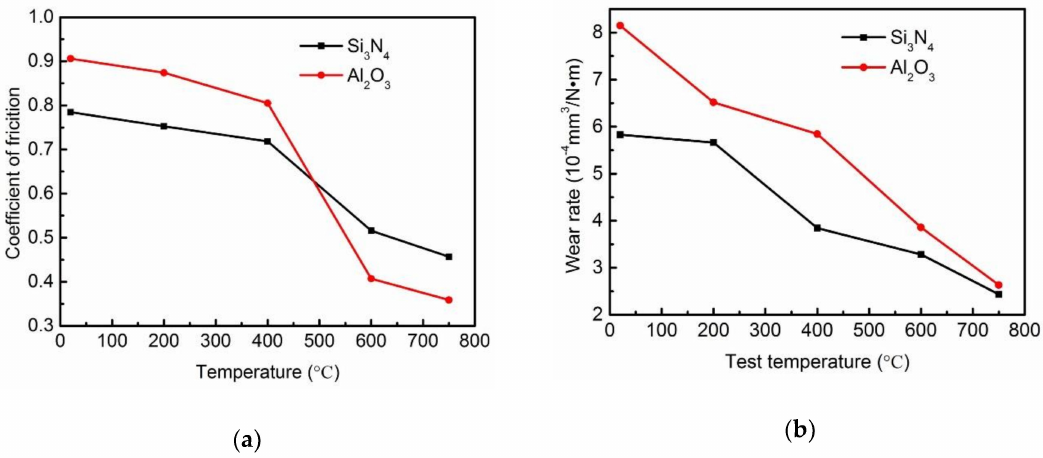
Figure 3. ( a ) Coefficient of friction (COF) of the alloy sliding against Al 2 O 3 and Si 3 N 4 at different temperatures, ( b ) the wear rate of the alloy sliding against Al 2 O 3 and Si 3 N 4 at different